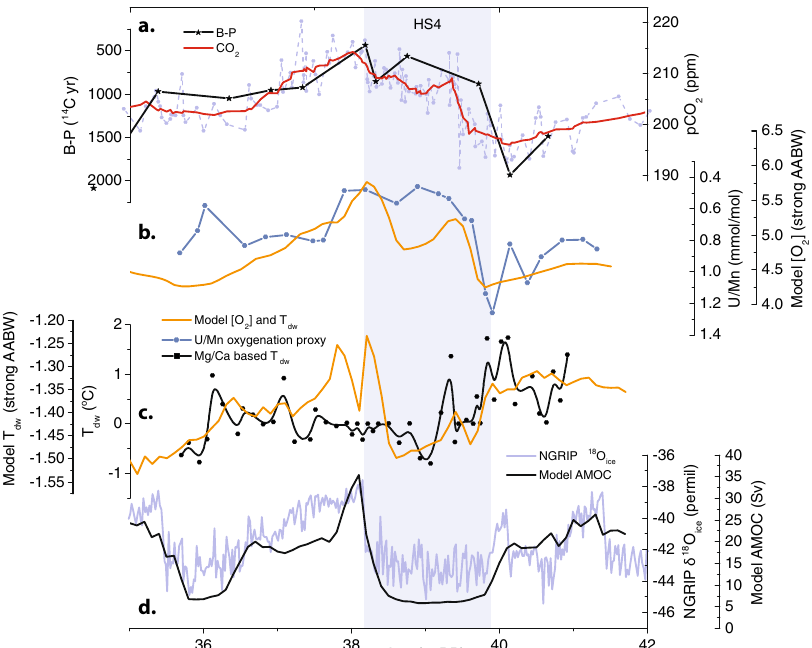
Fig. 3 Comparison of reconstructed and modelled deep-water temperatures and ventilation. Data from MD07-3076Q are compared with composites of simulations performed with the UVic and LOVECLIM Earth system models (experiments U-TrS and L-TrS from ref. 12 ), and atmospheric CO 2 change. a Atmospheric CO 2 (light blue fi lled circles and dashed line, and solid red line showing 3-point smoothing), compared with deep-water radiocarbon ventilation inferred from B-P radiocarbon age offsets 37 . b Reconstructed oxygenation based on authigenic U/Mn ratios of foraminiferal coatings 37 (solid blue circles and line), compared with simulated Southern Ocean deep-water oxygenation (solid orange line), based on a composite of outputs over 55 – 10° W, 50 – 75° S and 3300 – 4000 m. c Reconstructed deep-water temperature based on benthic Mg/Ca ( fi lled black circles, and b-spline solid line), compared with simulated Southern Ocean deep-water temperature (solid orange line). d Greenland δ 18 O ice event stratigraphy compared with simulated maximum Atlantic Meridional Overturning Circulation (AMOC) stream-function (solid black